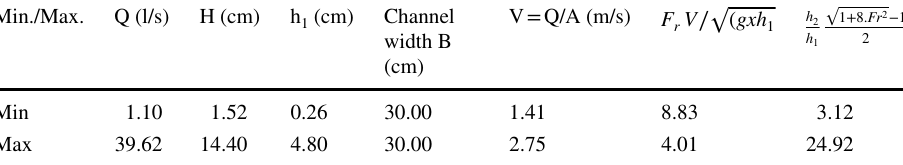
Table 1 Max and min values used for designing USBR Type III basin